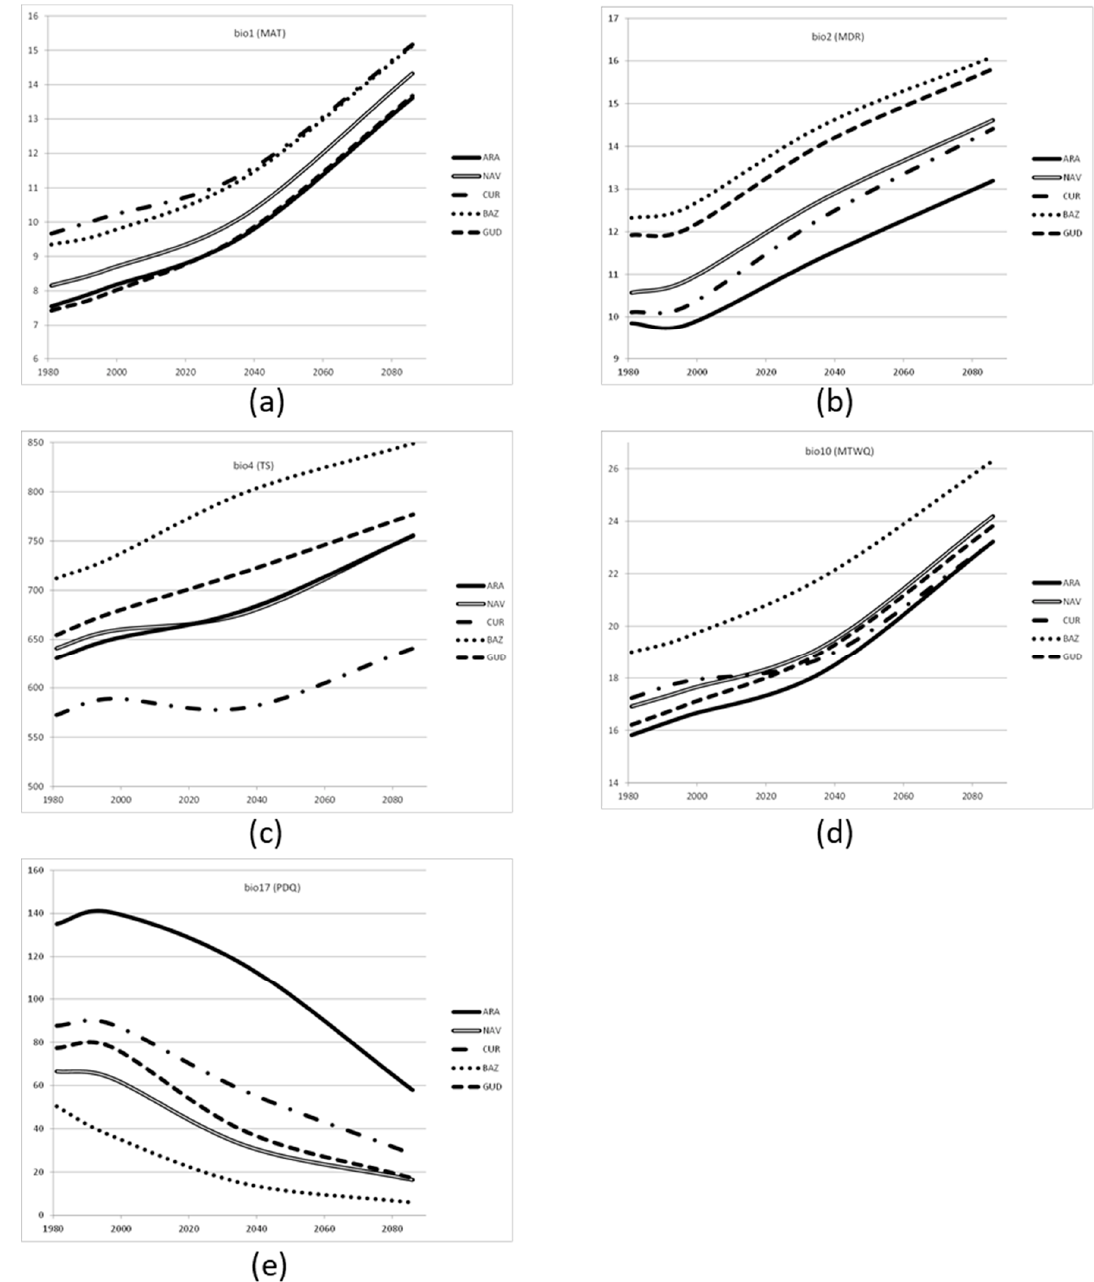
Figure A1. Projection of the climatic indices for the period 1980–2100 using the B4EST-DT geo-web service [https://ibbr.cnr.it/b4est/]. ( a ) bio1, MAT: Mean Annual Temperature, ( b ) bio2, MDR: Mean Diurnal Range, i.e., mean of monthly (max temp-min temp)), ( c ) bio4, TS: Temperature Seasonality (standard deviation ×100)), ( d ) bio10, MTWD: Mean Temperature of Warmest Quarter), ( e ) bio17, PDQ: Precipitation of Driest Quarter.